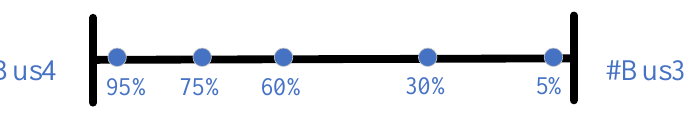
Figure 12. The line length.